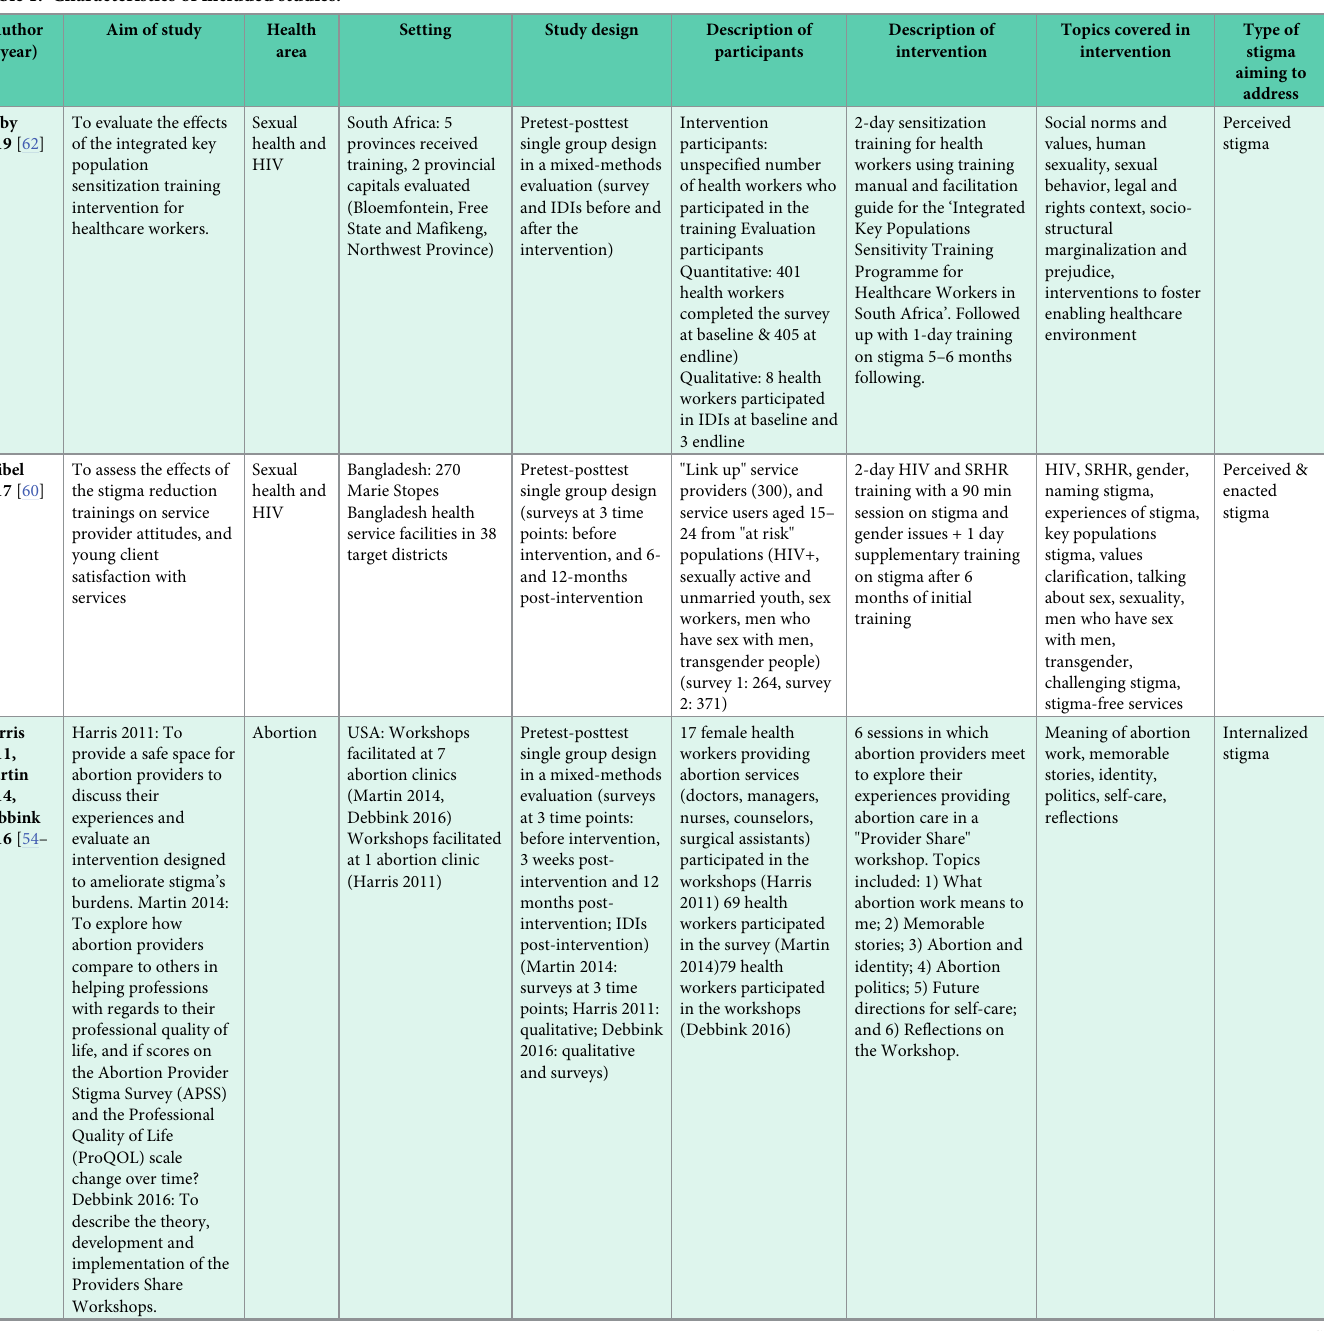
Table 1. Characteristics of included